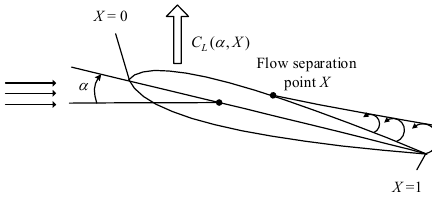
Figure 1. Trailing edge flow separation phenomenon.